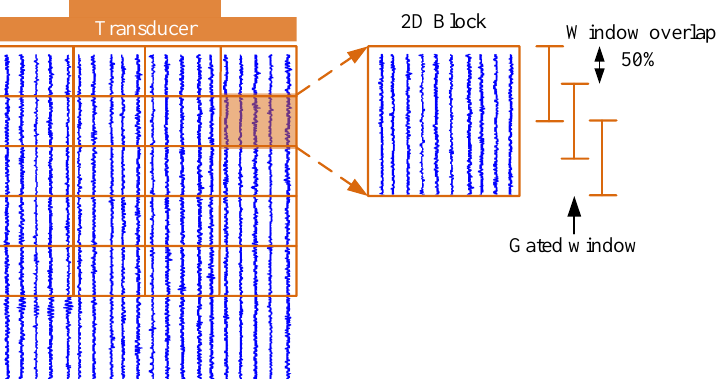
Figure 1. A 2D block diagram for computing the power spectrum.